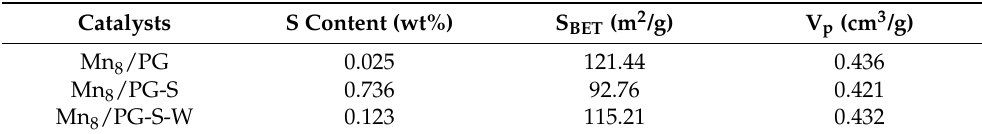
Table 1. S content, specific surface area and pore volume of the three catalysts.